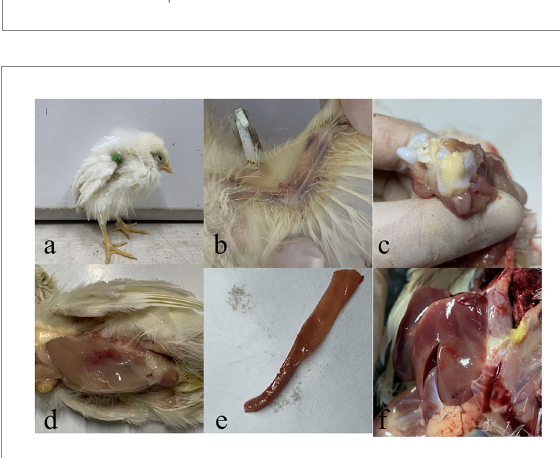
FIGURE 2 Digestion of the infectious clone plasmid. M 5000 DNA Marker, #1 original double-copies infectious clone plasmid, #2 digestion of the double-copies infectious clone.